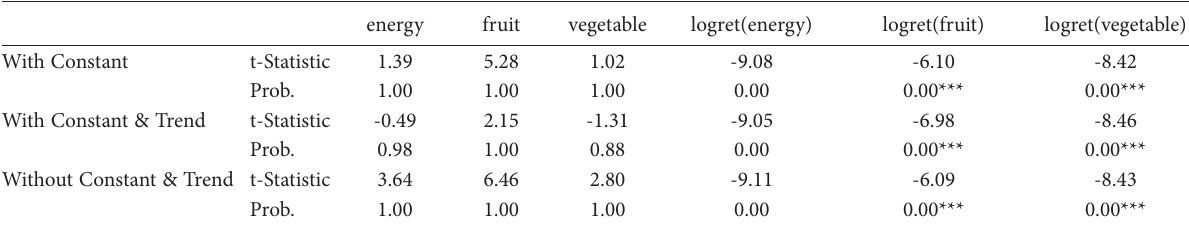
Table A2. Augmented Dickey-Fuller Unit Root Test Results.